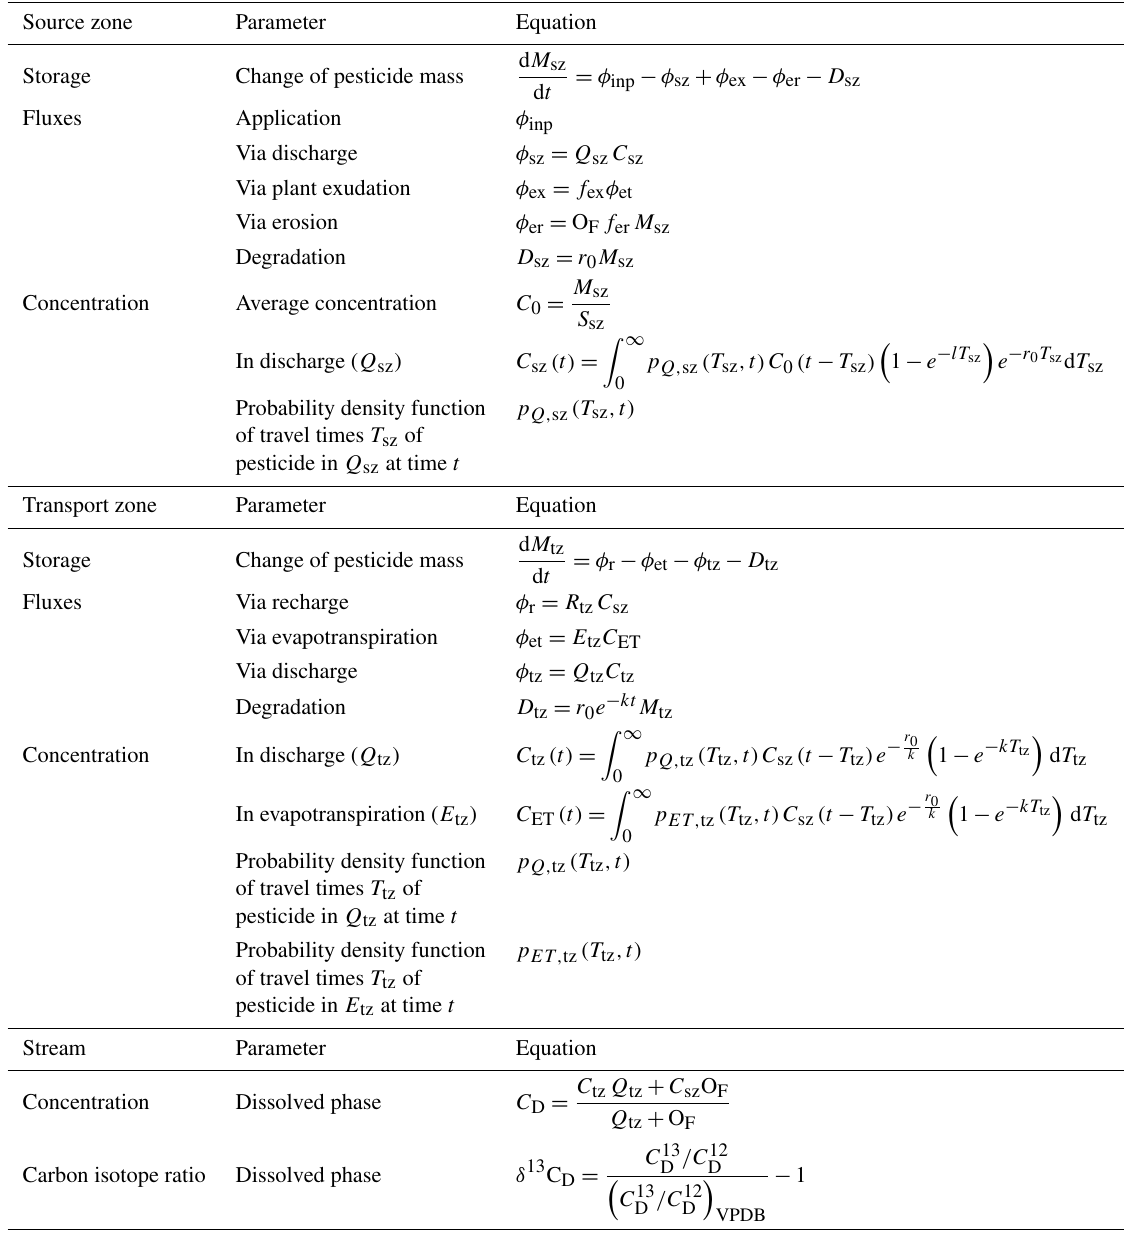
Table 2. Equations of the pesticide model. See also the explanation of parameters in Table 3. Source